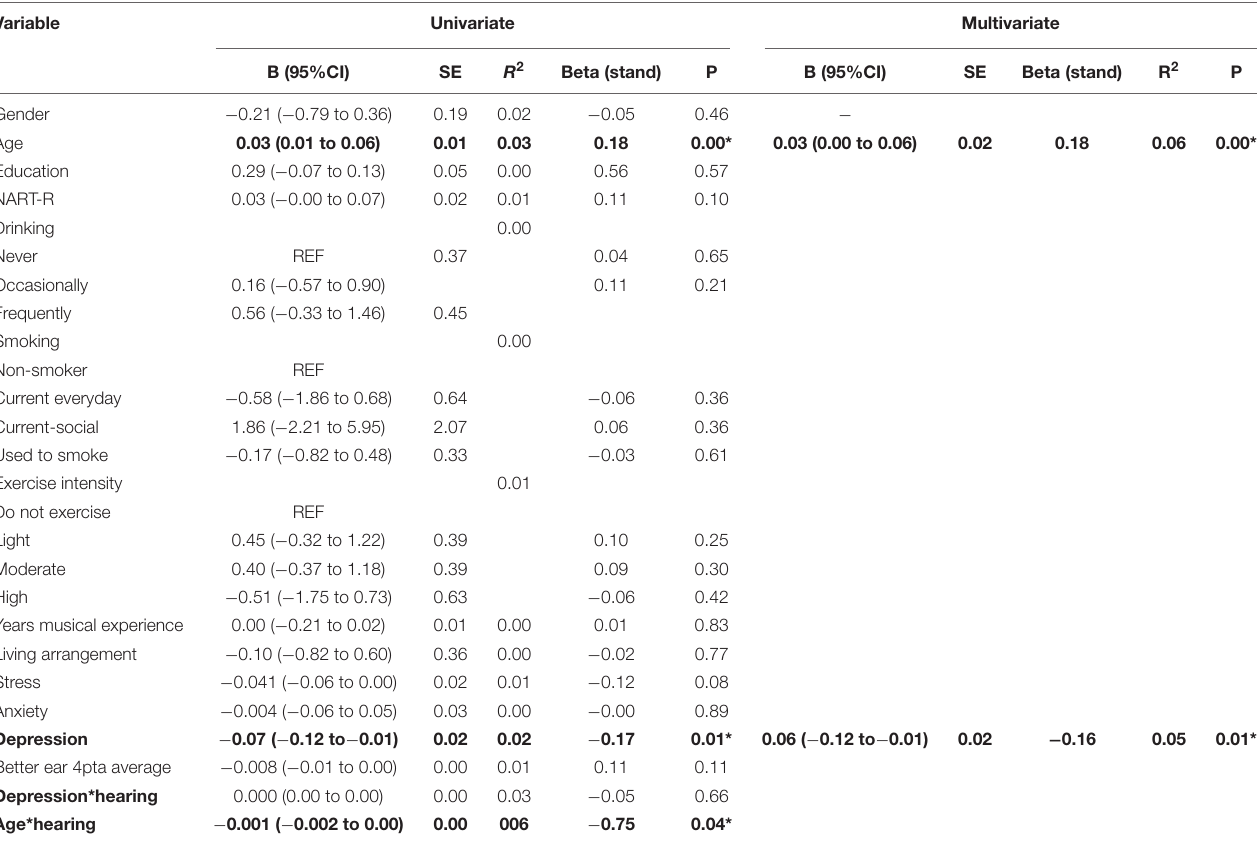
TABLE 4 | Univariate and multivariate analyses, social interaction